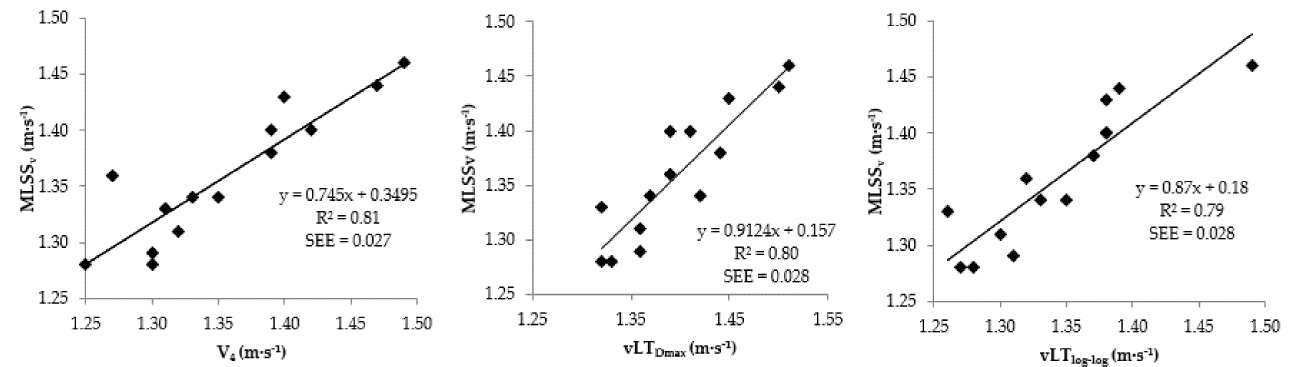
Figure 2. Linear regression of MLSS v on V 4 , vLT log-log , and vLT Dmax with standard error of estimate (SEE). The agreement between MLSSv and V 4 is shown in Figure 3. The 95% limits of agreement (Loa) ranged from − 0.059 to 0.066. Although the bias was 0.004 and there was no relation between the difference and the mean of the parameters there were somewhat wide limits of agreement ( ± 5.1%). The bias between MLSSv and vLT log-log was − 0.016 and the Loa ranged between − 0.039 and 0.072, representing a variation of ± 4.1% of MLSSv. There was not a significant trend between the difference and the mean of the two measures. The MLSSv was overestimated by the vLT Dmax with a bias of − 0.038 with somewhat wide Loa ranging between − 0.092 and 0.017, representing a variation of ± 4.1% of MLSSv. There was not a significant trend between the difference and the mean of the two